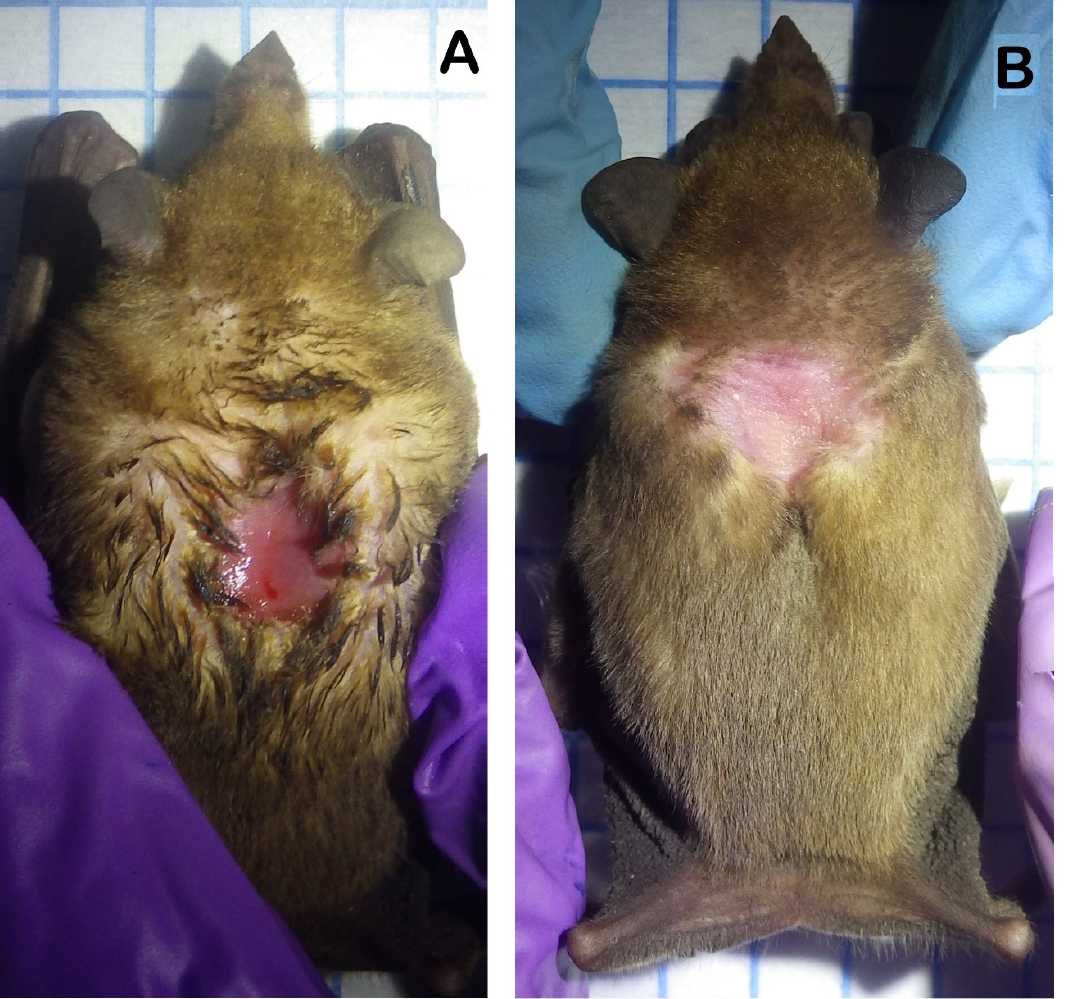
Figure 2. Male lesser long-nosed bats ( Leptonycteris yerbabuenae ) captured in west-central Mexico presenting different stages of development of their dorsal sebaceous patches. ( A ) shows a male with a fresh dorsal patch characterized by the irritation of the tissue and the presence of body fluids in the hair surrounding the patch. ( B ) shows a male with a dry dorsal patch in which there are no signs of body fluids in the surrounding hair and there is no tissue irritation.